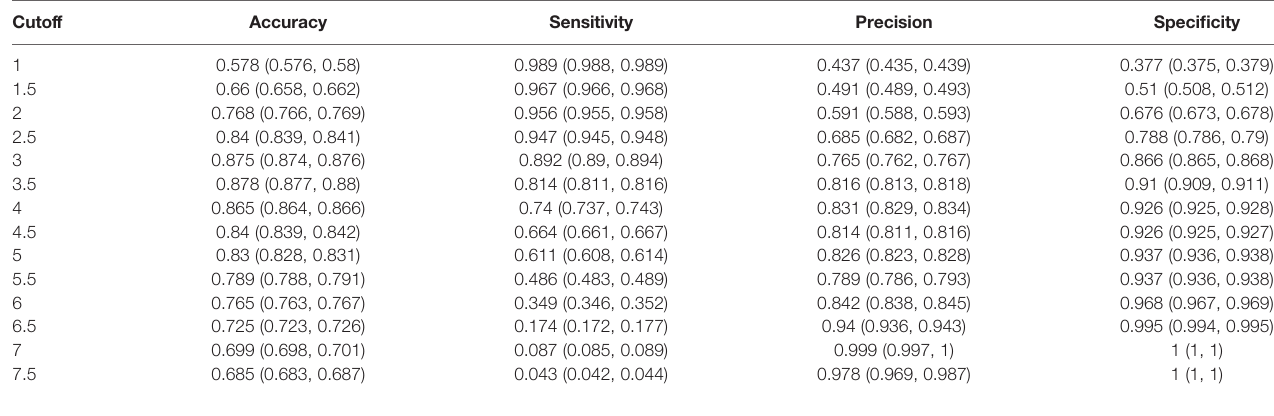
TABLE 2 | Cut-off values and corresponding performance data for the S1 scoring system based on three CT features, i.e., CT pre + Shape + necrosis or cystic degeneration (N/C), including an enhanced CT feature such as the N/C. Cutoff Accuracy Sensitivity Precision Speci fi